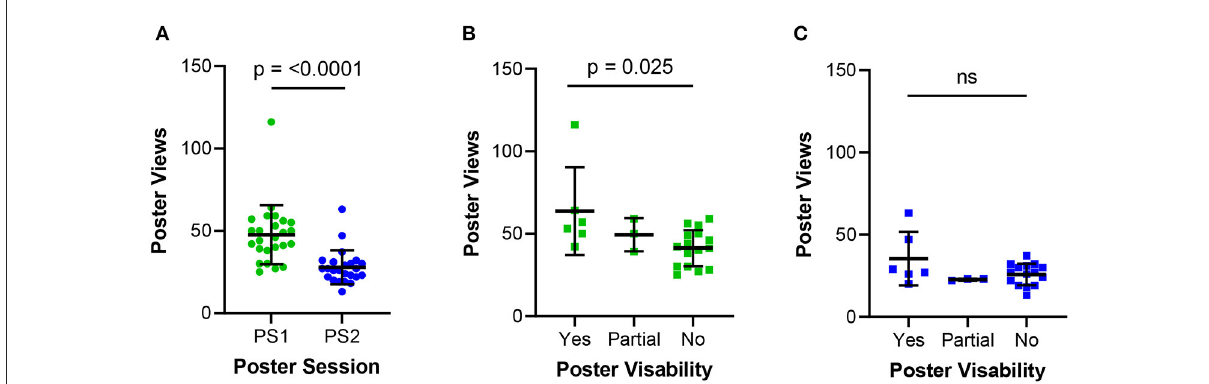
FIGURE3 Poster views during the two sessions. (A) Poster session views per poster for Poster Session 1 (PS1) and Poster Session 2 (PS2) on conference Day 1 and 2, respectively. (B) Poster views separated by initial visibility when navigating to the Poster Session features for PS1 and (C) PS2. Error bars represent standard errors of mean. Statistical analysis by Levene’s test and ANOVA [Poster Session 1: Levene’s test ( p -value = 0.476), one-way ANOVA ( p -value = 0.025); Poster Session 2: Levene’s test ( p -value = 0.121), one-way ANOVA ( p -value = 0.09)]. ns, not significant represents a p -value >